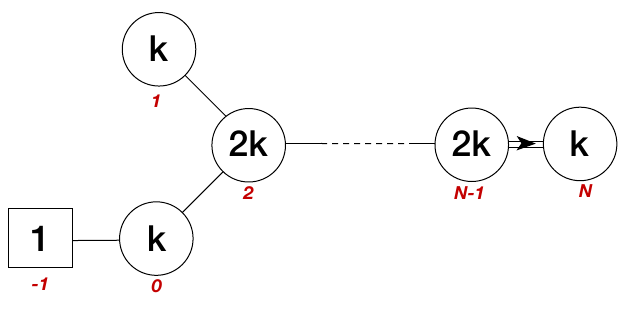
Figure 1 . The framed a(cid:14)ne B N quiver, also denoted by [ b B N ], with ranks of the unitary groups written black and node labels in written red.